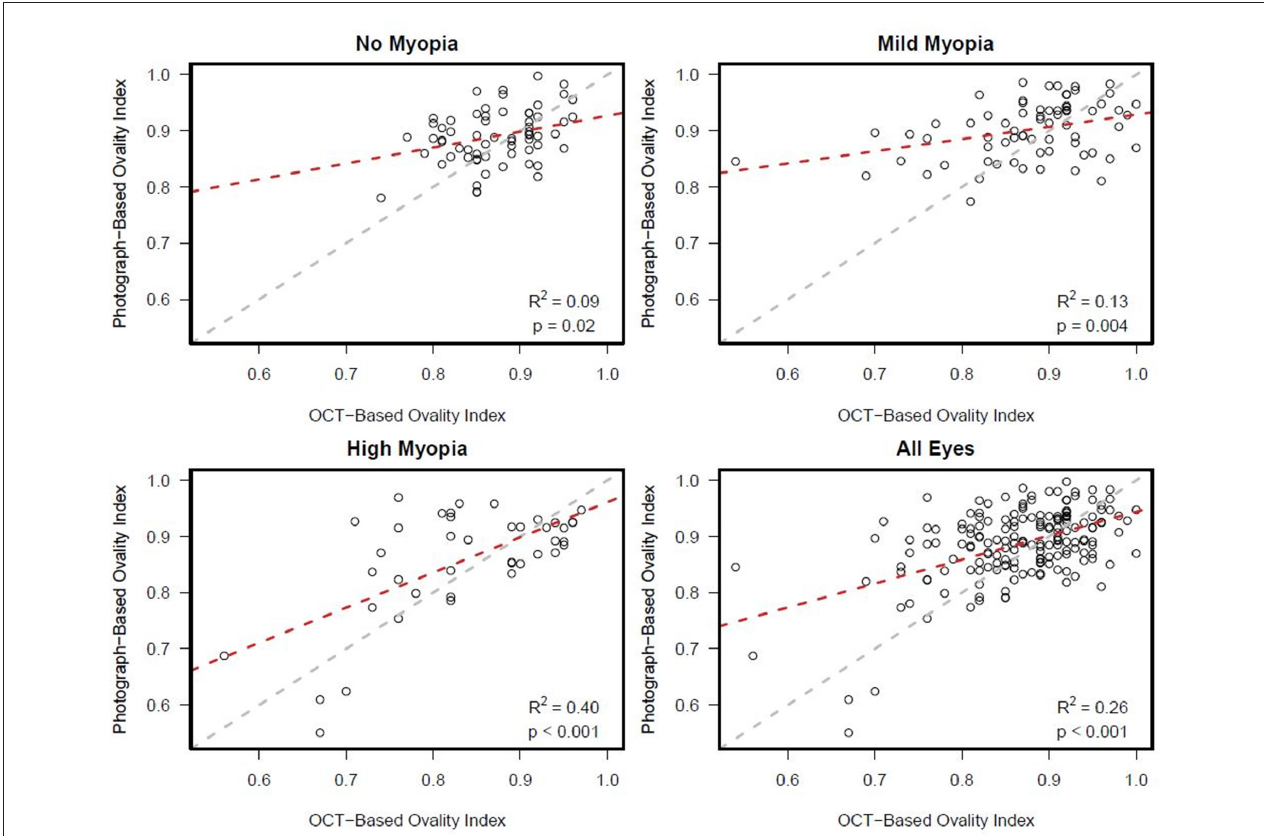
FIGURE 3 | Ovality index: Scatterplots showing stronger associations between semi-automated clinical disc margin photograph-based ovality index and automated, BMO OCT-based ovality index in eyes with axial high myopia compared to eyes with mild or no axial myopia.